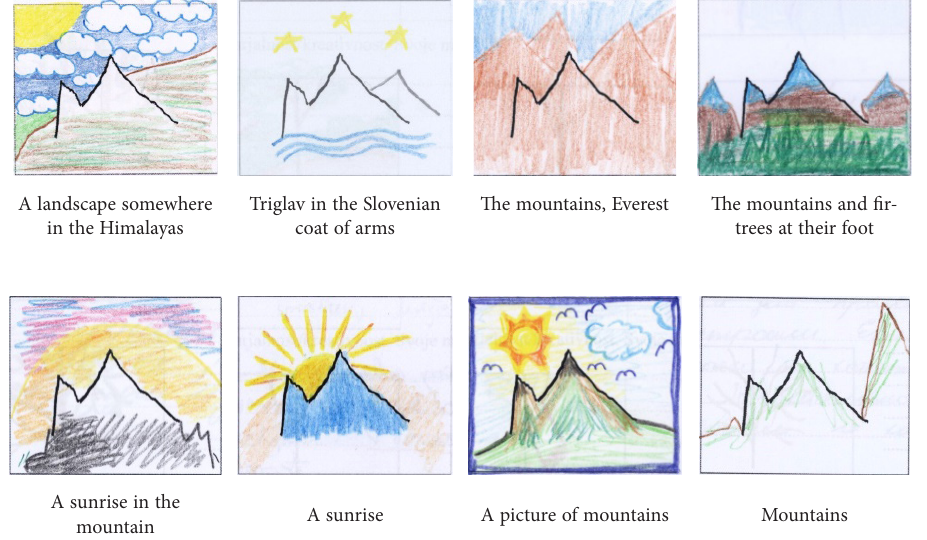
Figure 25. The creative task: interpretation of Fragment 4 – mountains (source: testingmom.com,